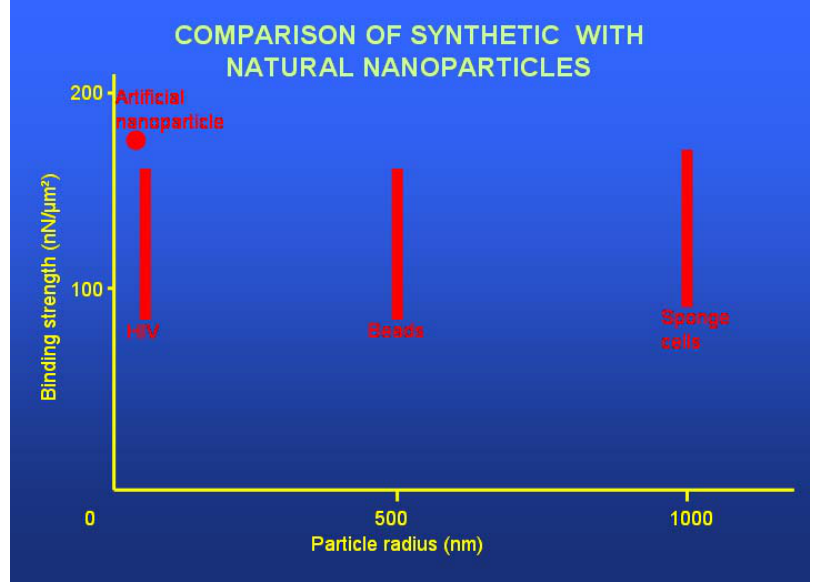
Figure 8. The density and strength of molecule pair interactions is invariant across the nanometer-micrometer size range from 20-100 nm diameter as shown by the artificial nanoparticles and the HIV virion, to approximately 1 micrometer, as shown by the sponge cells: the magnitude of the interactions is constant as shown by the horizontal pattern formed by the interaction